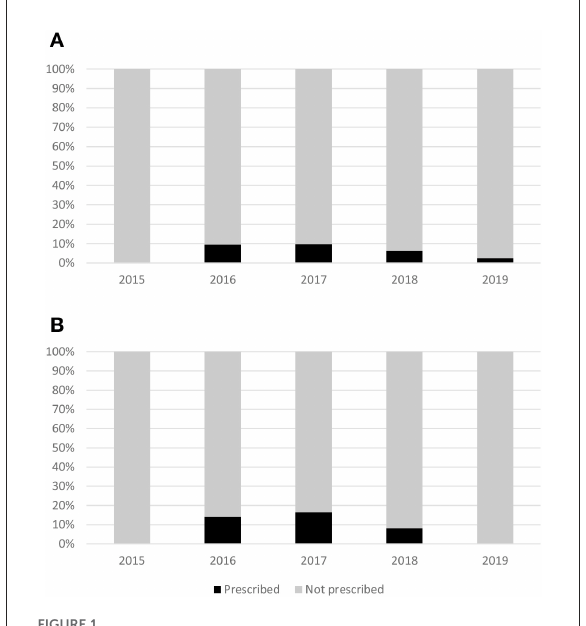
FIGURE1 Trend of prescribing metformin for diabetes prevention for the overall population (A) and patients that are more likely to benefit from metformin (B)